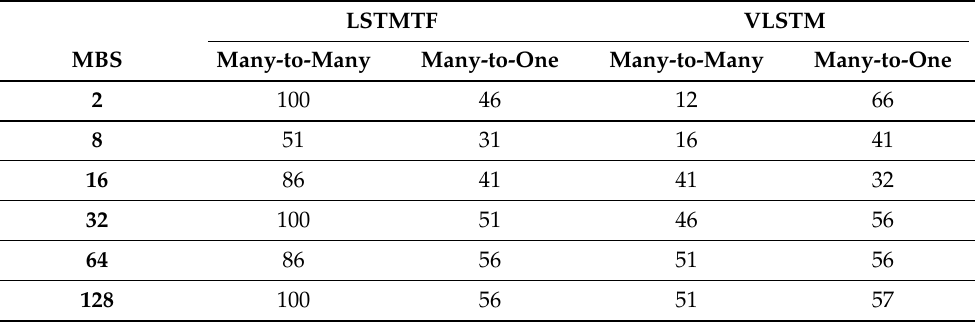
Table 5. The training convergence time (epochs) for LSTMTF and VLSTM, computed with respect to the mini-batch size, for (cid:101) = 1% and P =